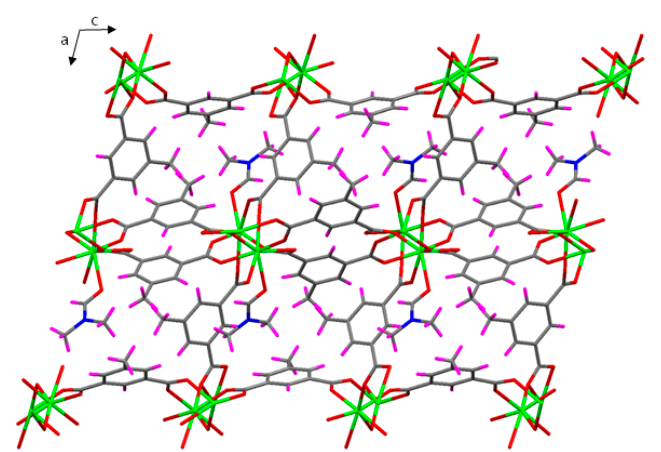
Figure 2. Crystal packing of compound 2 Eu showing the alternating propagation of the metal-carboxylate rods along b axis.